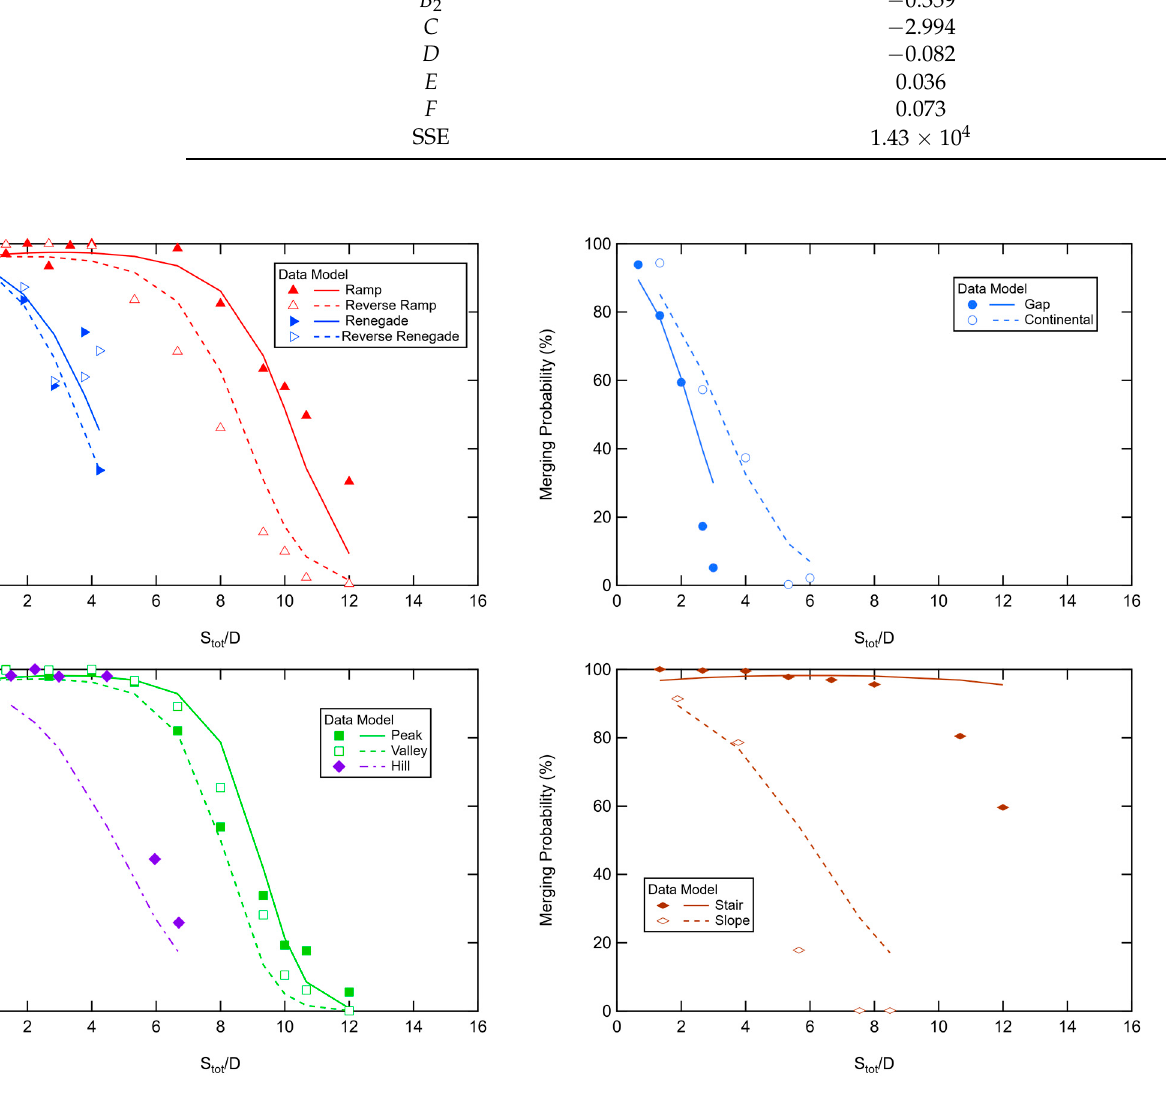
Figure 10. Merging probability ( PM ) as a function of normalized distance for the three-pad experiments. Lines are the curve fit using Equation (7). Configurations are shown in Figure 2.